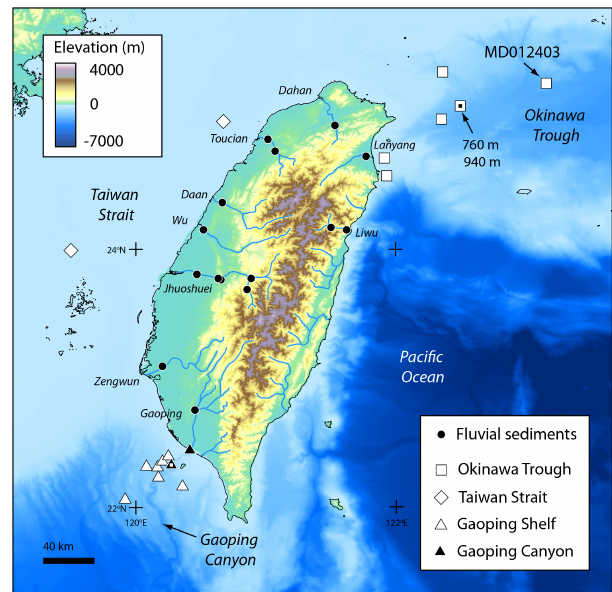
Figure 1. Location of terrestrial and marine samples from Taiwan and the surrounding ocean used in this study. River sediments were collected during typhoon floods across the island (black circles) with the sampled river names indicated (Table S1). Marine sam- ples fed by dispersive fluvial inputs (white symbols) were obtained from box core surface sediments, with the location of the longer pis- ton core MD012403 indicated. Sediments were also acquired from within the Gaoping Canyon (black triangles), which is fed by hy- perpycnal river plumes. Sediment traps (indicated by squares within symbols) were deployed in the Okinawa Trough (depths provided) and at 608 m in the channel of the Gaoping